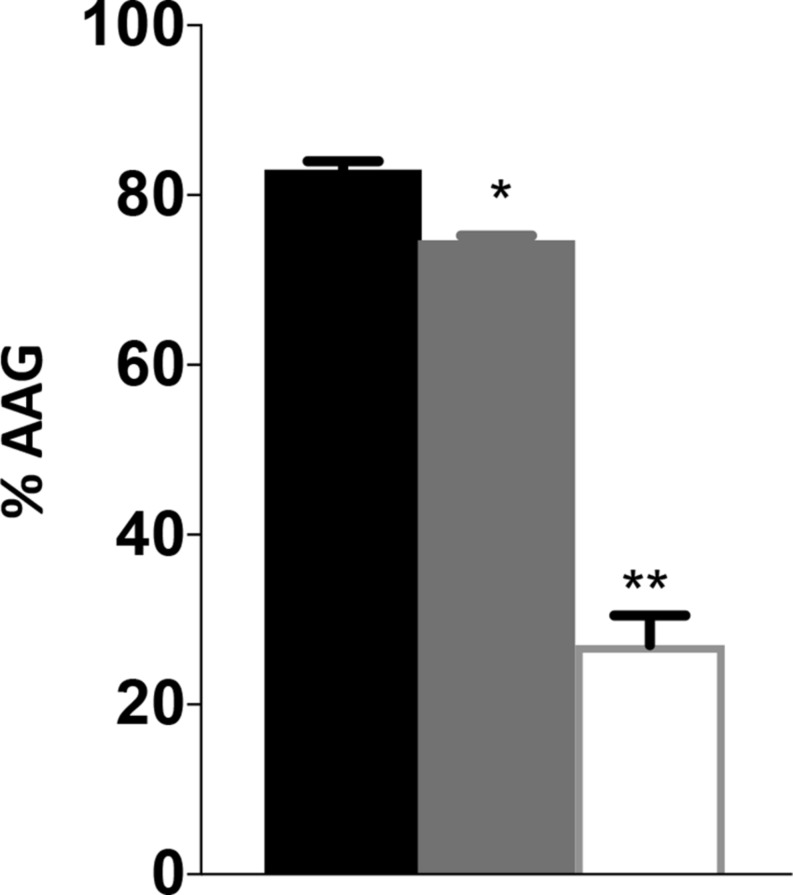
Campylobacter jejuni ridA mutants have an autoagglutination defect during the first 24 h. Autoagglutination was measured using C. jejuni wild type (black), a cjridA mutant (light gray) and a pseC mutant (white). % AAG represents the percentage of cells that autoagglutinated and settled in the bottom of the tube after 24 h, determined by the formula [(OD600i–OD600r)/OD600i] × 100. Error bars represent the standard errors of the mean of three technical triplicates, for wild type and pseC mutant, and two biological replicates in technical duplicate for cjridA mutants. Significance was determined between each mutant and wild type. One asterisk denotes statistically significant (P < 0.005) and two asterisks denote statistically significant (P < 0.0005) variation between mutants, as determined by an unpaired Student t test performed with GraphPad Prism software, v7.0C.